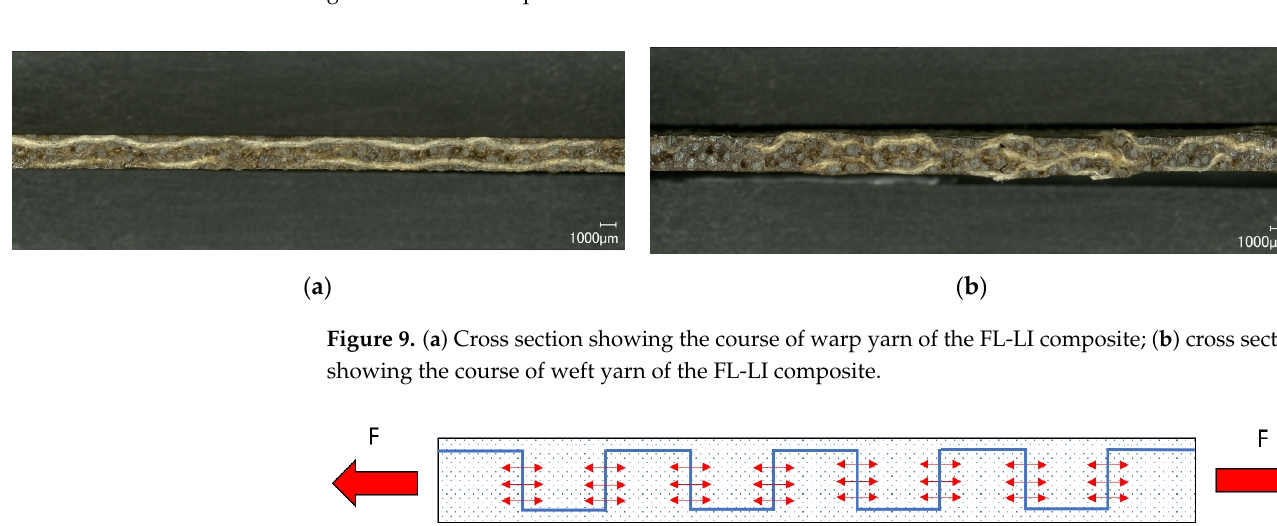
Figure 10. Load transfer directions of the weft yarn during the tensile test with idealised yarn course. The red arrows indicate the force (F). The blue line shows the weft yarn in the matrix background.